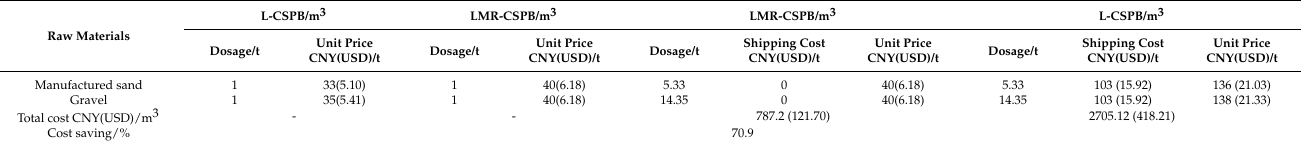
Table 10. The technical and economic analysis of preparing